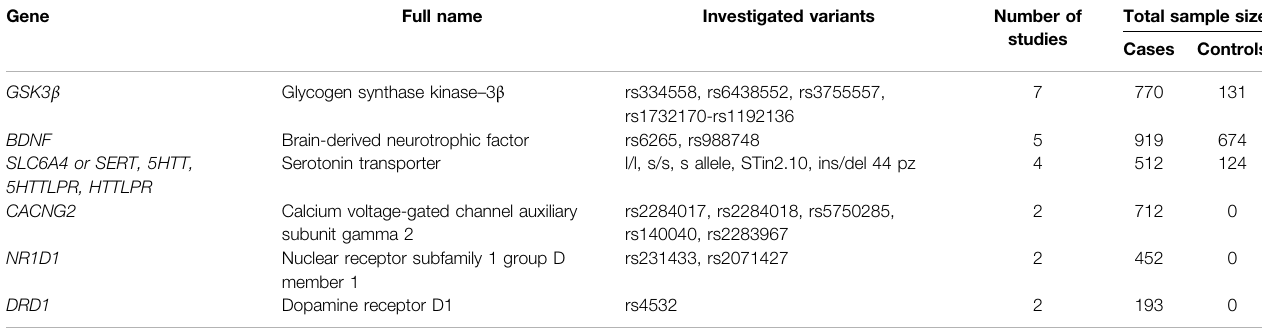
TABLE 3 | Characteristics of gene studies with evidence for effect on lithium response. Only those genes are listed where at least two studies reported the same